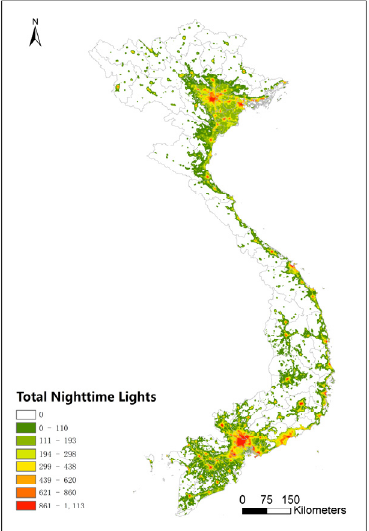
Figure 2. Image of night lights in Vietnam from 2000 to